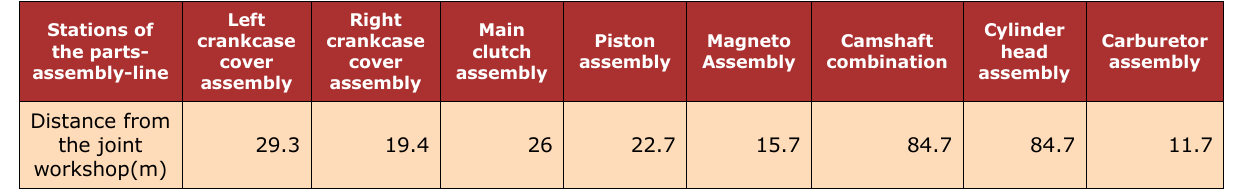
Table 1. The distance between Joint workshop staging area and the each station of assembly line